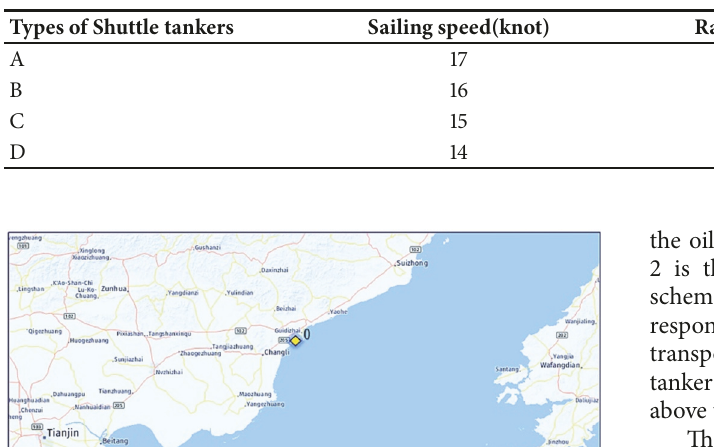
Table 3: Basic operating parameters of shuttle tankers.